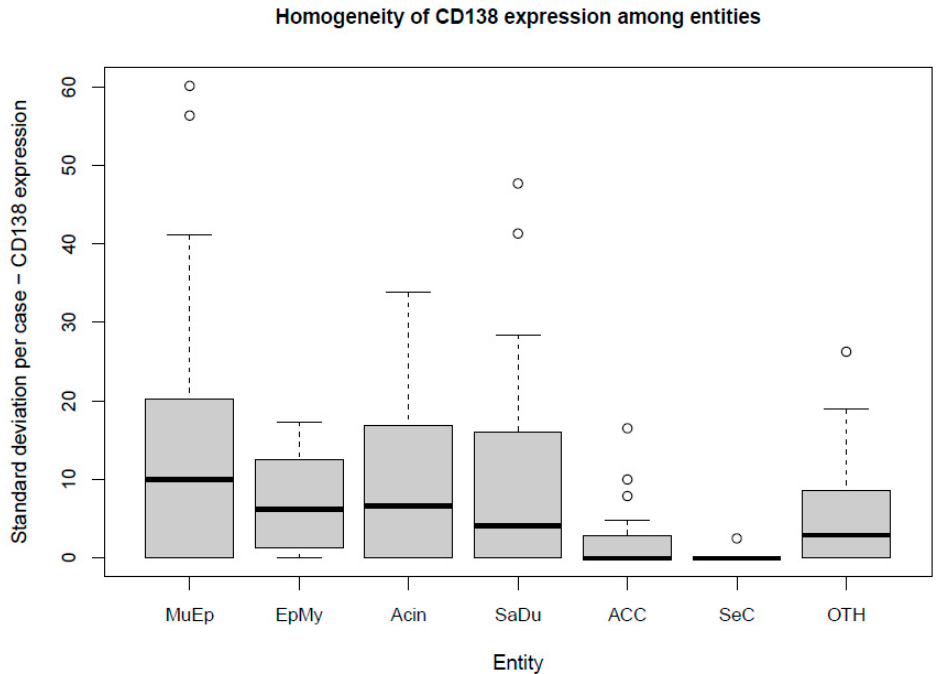
Figure 3. Box plot displaying the homogeneity of CD138 expression among the most frequent entities. MuEp = Mucoepidermoid carcinoma, EpMy = Epithelial-myoepithelial carcinoma, Acin = Acinic cell carcinoma, SaDu = Salivary duct carcinoma, ACC = Adenoid cystic carcinoma, SeC = Secretory carcinoma, OTH = Others. ◦ Outliers. Besides the primaries, CD138 expression was studied in 13 loco-regional lymph node metastases originating from SaDu. A markedly more frequent CD138 expression with a mean of 31.2% (±35.4) of tumor cells being positive for CD138 was found in the SaDu lymph node metastases compared to the SaDu primaries (15.2% (±22.0)) (Figure 4). For SaDu, CD138 expression in primaries correlated with expression in lymph node metasta- ses ( p = 0.01; Spearman’s ρ = 0.71) (Figure 5).